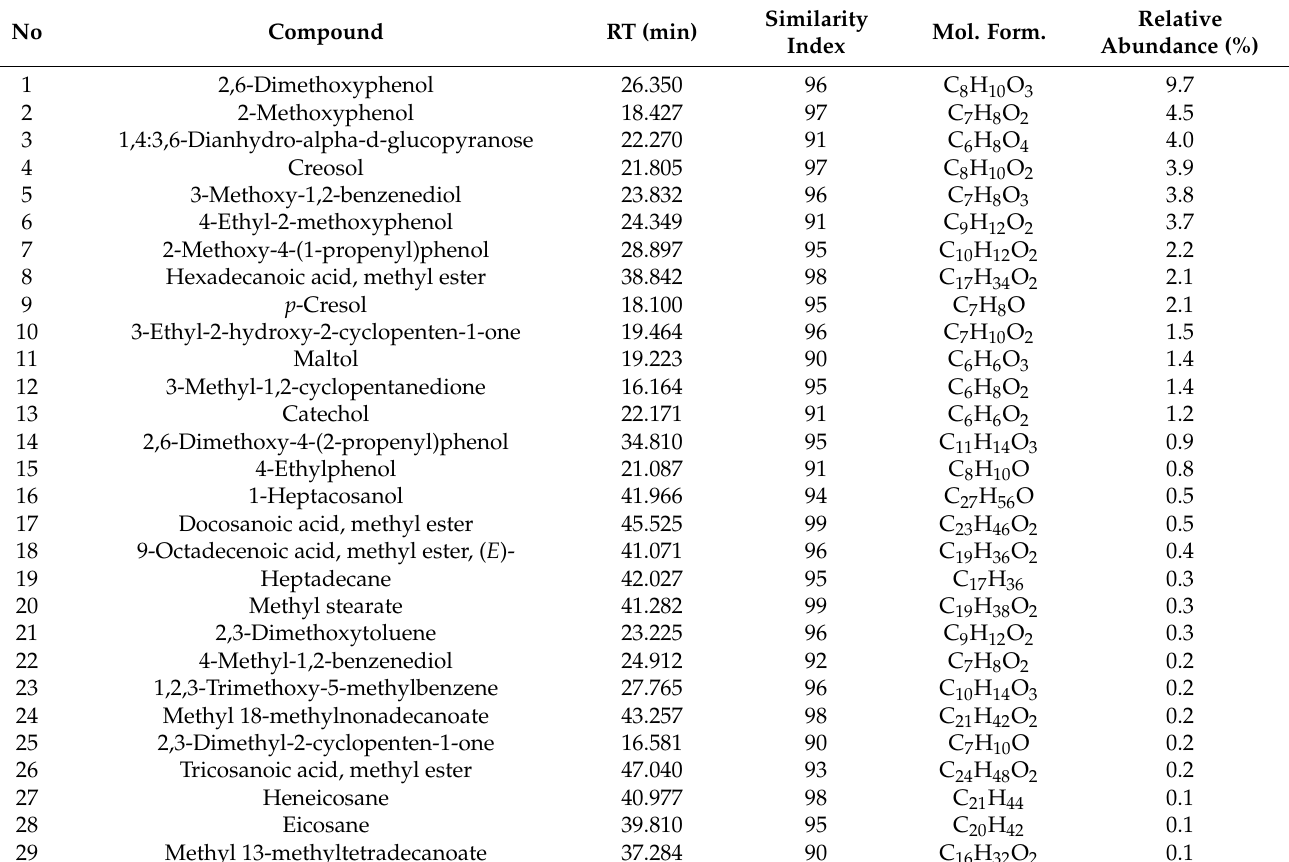
Table 5. Chemical composition of hemp hurds (HR1) distillates from pyrolysis stage (PS) condensed at 130 ◦ C and analyzed by